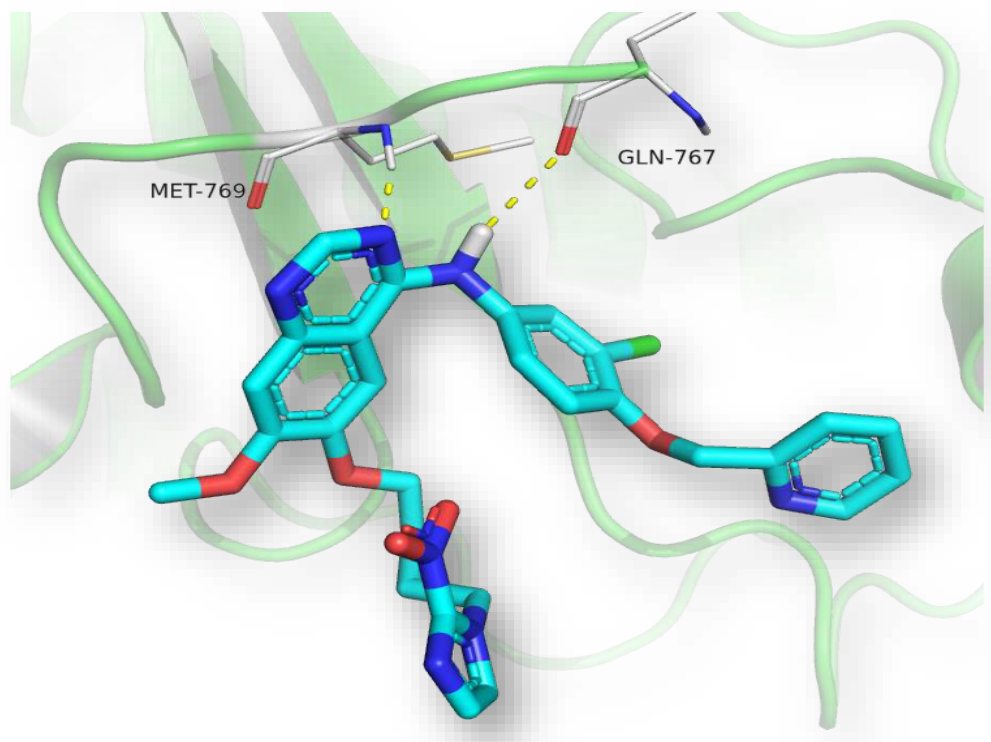
Figure 7. Compound 6j H-bond interactions with hinge residue in 1M17.